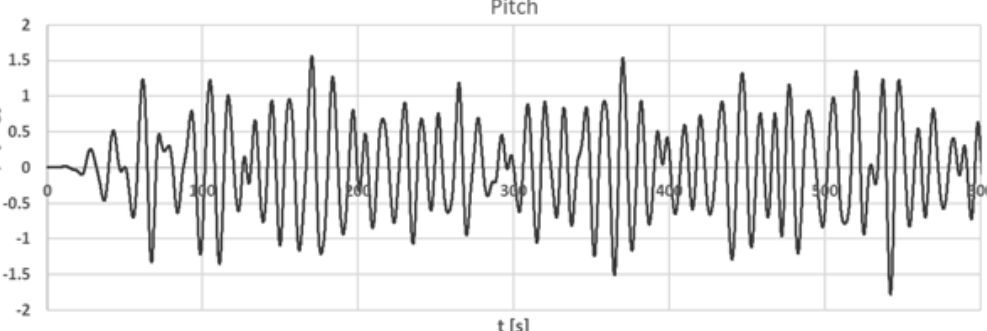
Figure 19. Pitch response to IW8 according to the coupled time − domain solver SESAM DeepC ® .